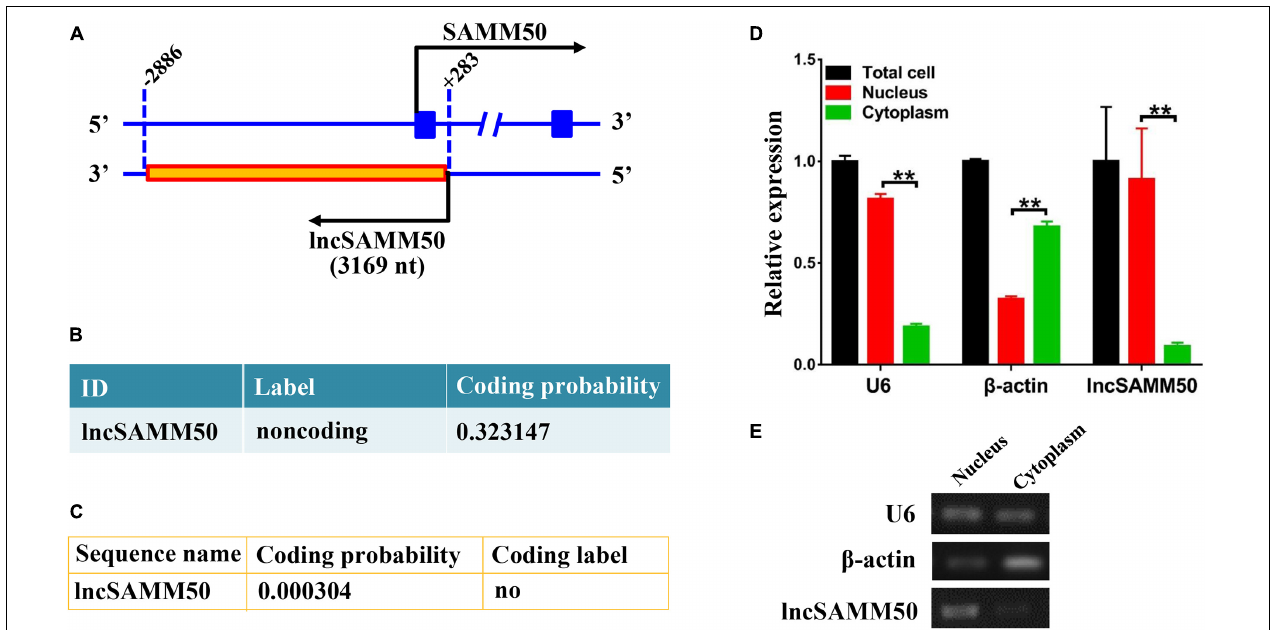
FIGURE 2 | Characterization of buffalo lncSAMM50. (A) Positional relationship between SAMM50 and lncSAMM50. (B) The Coding Potential Calculator (CPC) program suggests that lncSAMM50 is a non-coding RNA. (C) The Coding Potential Assessment Tool (CPAT) indicates that lncSAMM50 is a non-coding RNA. (D) Cell localization of lncSAMM50 by qRT-PCR. Adipocytes induced to differentiation for 6 days were used for separation of nucleus and cytoplasm RNA. U6 and β -actin were respectively used as nuclear and cytoplasmic markers. The 2 − (cid:49) Ct method was used to calculate the gene expression level. Data are presented as the mean ± SD ( n = 3; ** p < 0.01). (E) Cell localization of lncSAMM50 by semiquantitative